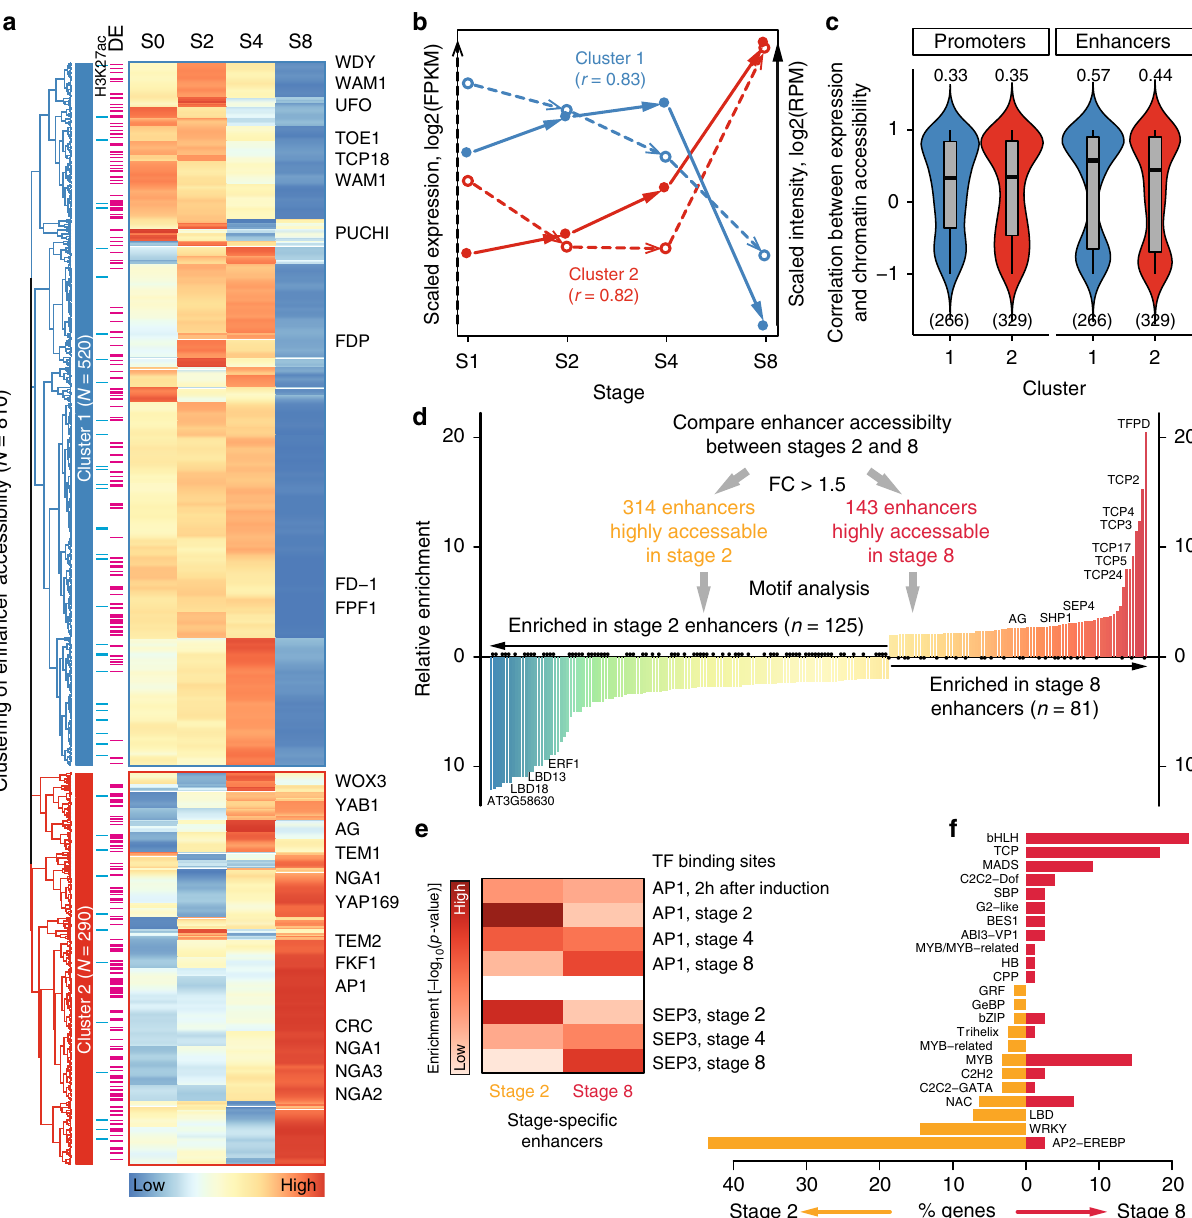
Fig. 6 Enhancers control developmental stage-speci fi c gene expression programs. a Heatmap illustrating the clustering analysis of 810 enhancers whose accessibility dynamically changes for more than 1.5-fold across the four stages (from stages 0 [S0] to 4 [S4]). The enhancers are grouped into two clusters. The blue bars on the left of the heatmap indicate that there are H3K27ac peaks for the corresponding enhancers. Pink bars indicate that the nearest genes are differentially expressed (DE). Flowering genes are labeled on the right of the heatmap. b The median expression level (in dashed arrow) and enhancer accessibility (in solid arrow) across developmental stages for the genes from the two clusters in a . Pearson correlation coef fi cients r between gene expression and enhancer accessibility for each cluster are shown in parentheses. c Violin plots (with boxplots inside) showing the Pearson correlation coef fi cient between expression level and chromatin accessibility for each gene in different clusters. Promoters with respect to the enhancers in each cluster were used for comparison. The median correlation coef fi cient is shown above the violin plot. The number of genes used in the analysis is indicated in parentheses. Note that genes with missing expression data were removed from the analysis. d Identifying stage-speci fi c enhancers at stages 2 and 8. Histogram shows enriched motifs in the stage-speci fi c enhancers. Only motifs showing at least twofold changes in enrichment between stages 2 and 8 are plotted. e Enrichment analysis of AP1 and SEP3 binding sites (time-course ChIP-seq data from refs. 18,72 ) in stage-speci fi c enhancers. Heatmap shows log10-transformed p -values from hypergeometric tests. f Overview of TF families for TF genes with enriched motifs as shown in d . The underlying source data for a – f are provided in the Source Data fi